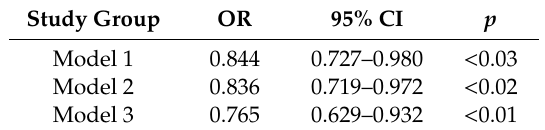
Table 4. Odds ratio (95% CI) by multiple logistic regression analysis for the risk to develop T2DM. Study Group OR 95% CI p Model 1 0.844 0.727–0.980 < 0.03 Model 2 0.836